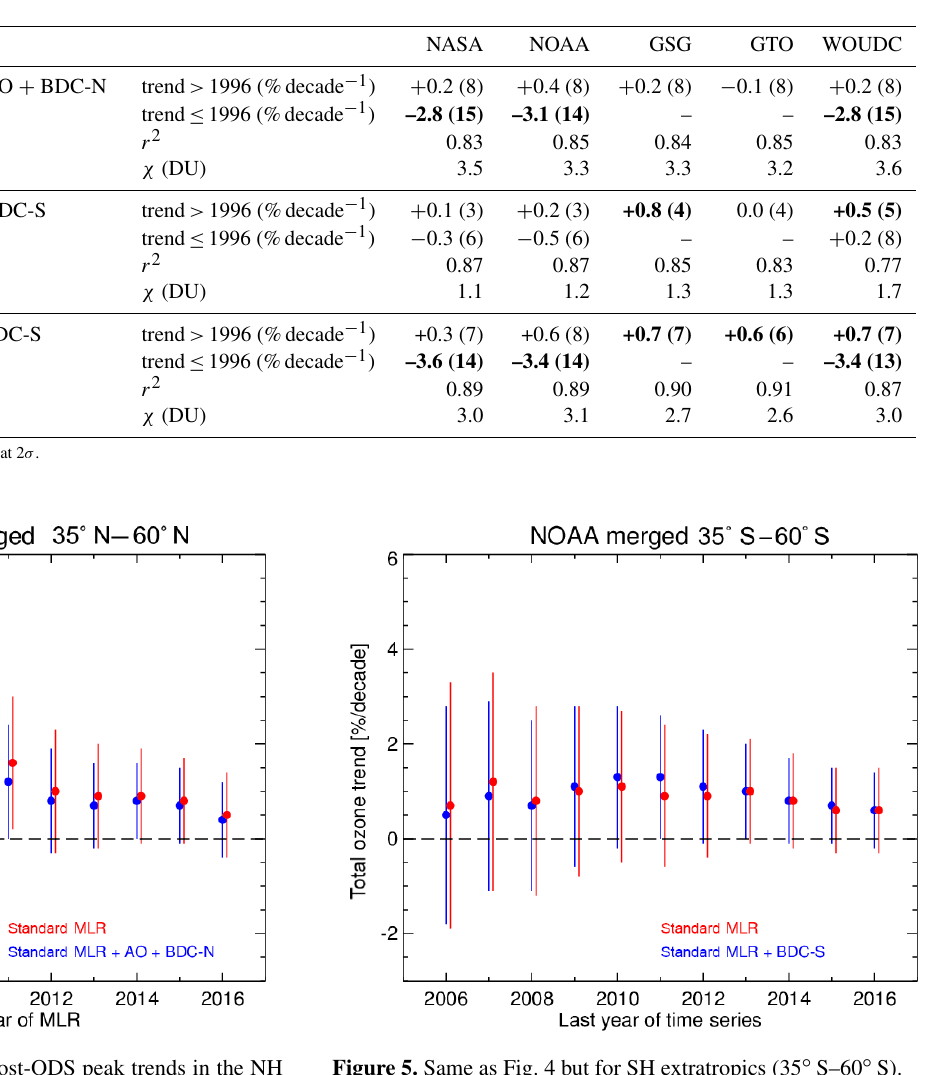
Table 3. The 1979–1996 and 1997–2016 annual mean total ozone trends in broad zonal bands. Uncertainties are provided for 2 σ and trends in bold indicate statistical significance. r 2 is the squared Pearson correlation and χ the residual defined as χ 2 = P i ( obs i − mod i ) 2 /(n − m) , where obs i are the observations and mod i the MLR model, n the number of data (years) in the time series, and m the number of parameters fitted. In the NH, standard MLR plus AO and BDC-N terms were used; in the SH and tropics, standard MLR plus the SH BDC term were used. DU indicates Dobson units.